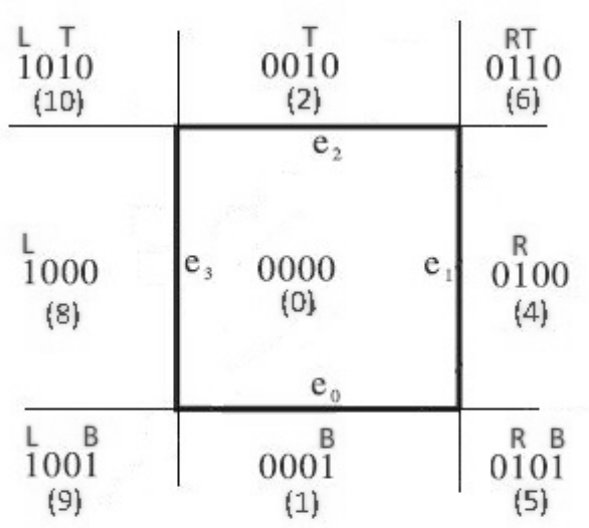
Figure 19. Screen is divided into 9 regions.